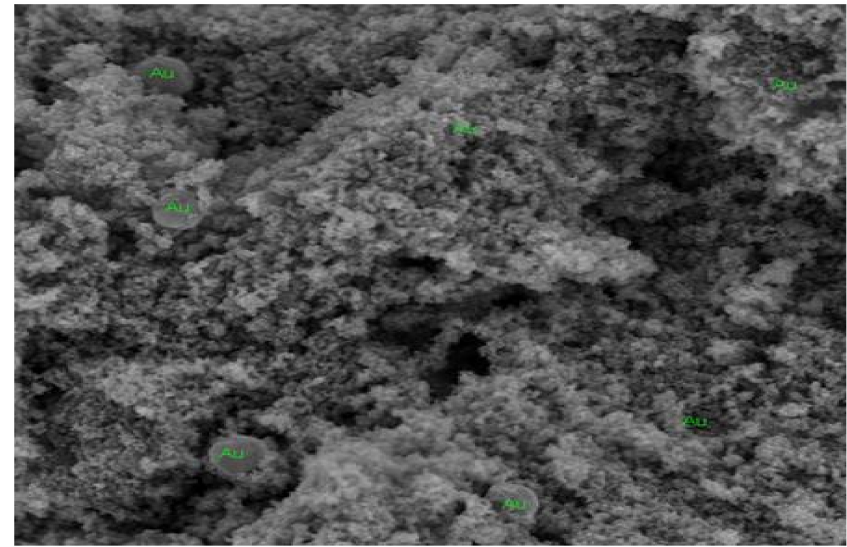
Figure 1. Scanning electron microscopy images of titanium catalysts doped with gold particles. Microscopy image showing the surface of the catalyst with a concentration of 5% (theoretical) of deposited gold.